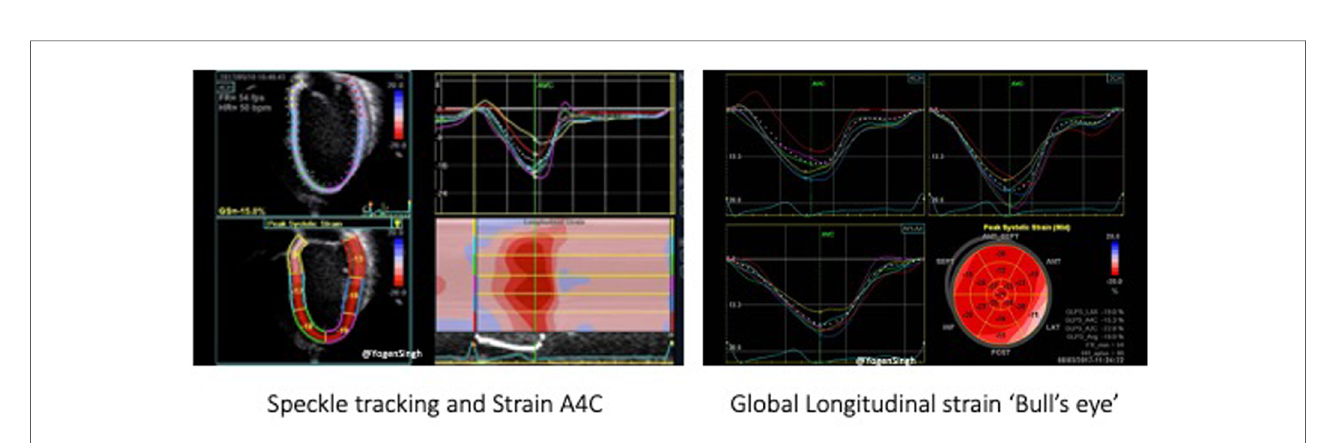
FIGURE 8 Myocardial strain measurements on two-dimensional speckle tracking